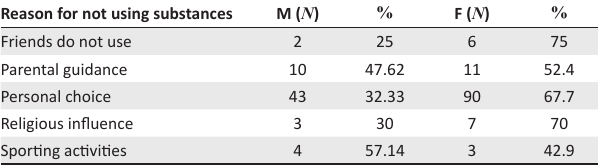
TABLE 6: Reasons for not using substances ( n = 179).